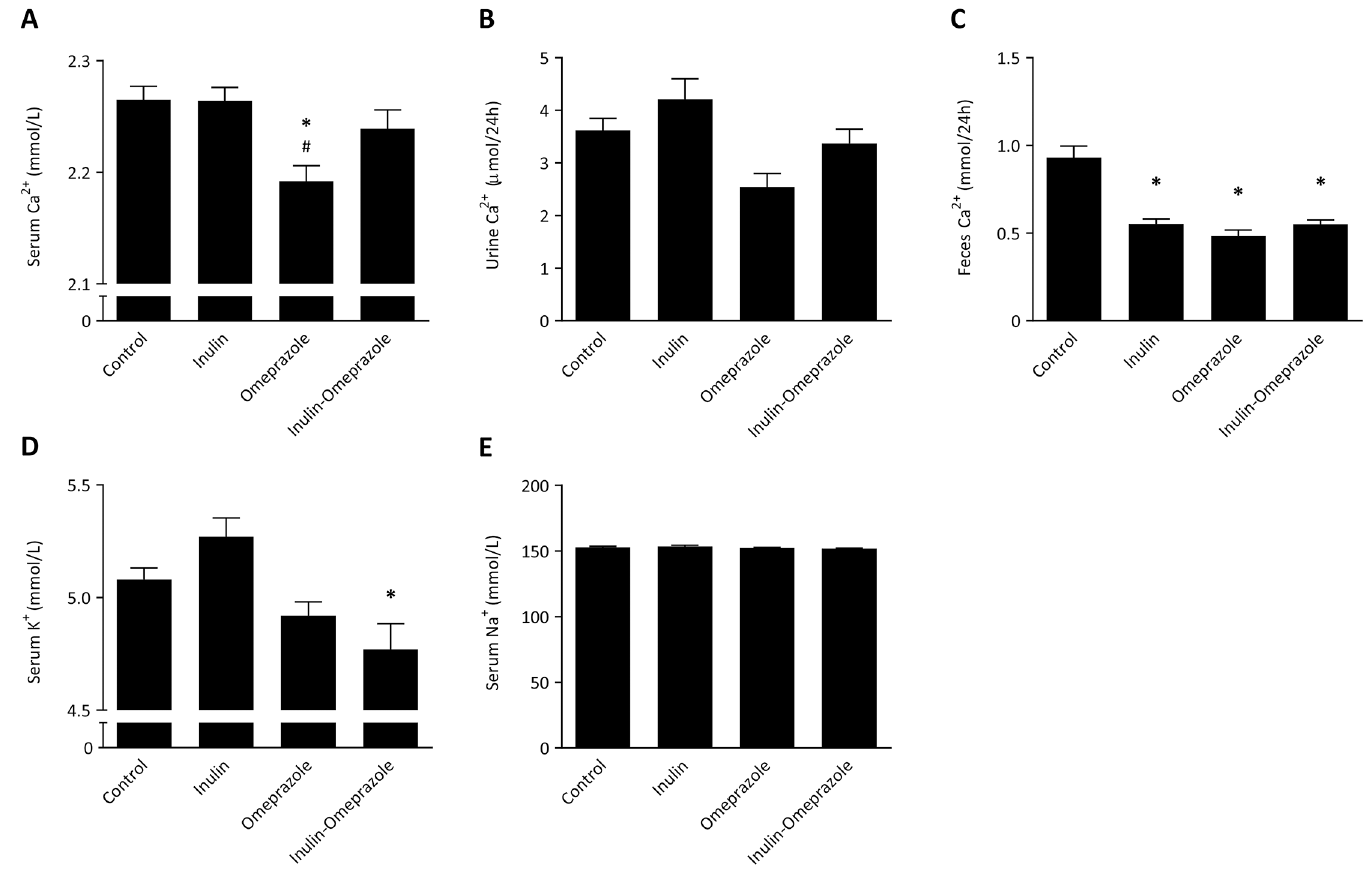
Fig 3. Effects of the combinatory application of omeprazole and 10% inulin enriched diets on electrolytes. Serum Ca 2+ concentration (A), 24 h urinary Ca 2+ excretion (B), 24 h fecal Ca 2+ excretion, serum K + concentration (D) and serum Na + concentration (E). Significant differences compared to control are indicated by * with P < 0.05, significant differences between the omeprazole-treated groups are annotated by # with P < 0.05. Bars represent means ± SEM, with n = 10 mice per group.